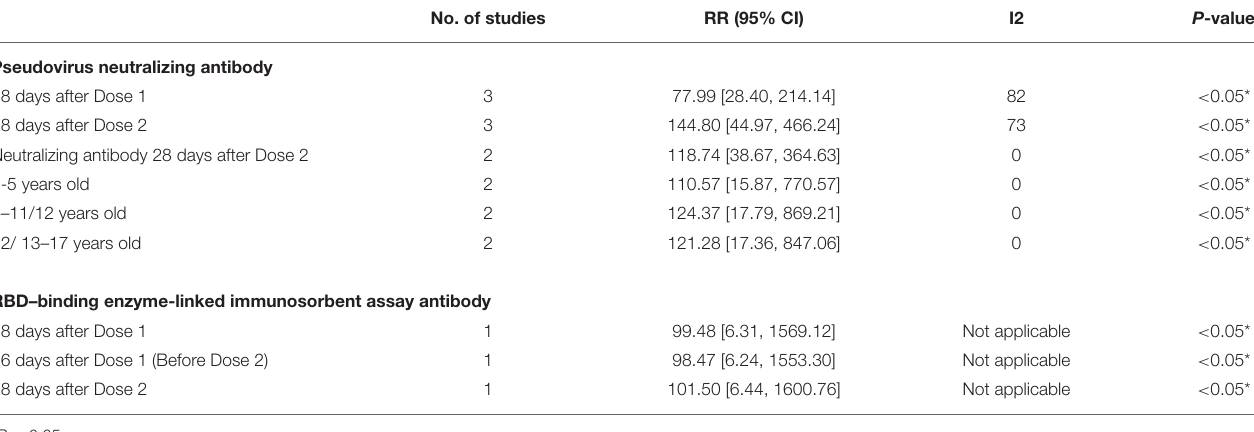
TABLE 8 | Seroconversion rate in vaccine group vs. control group.